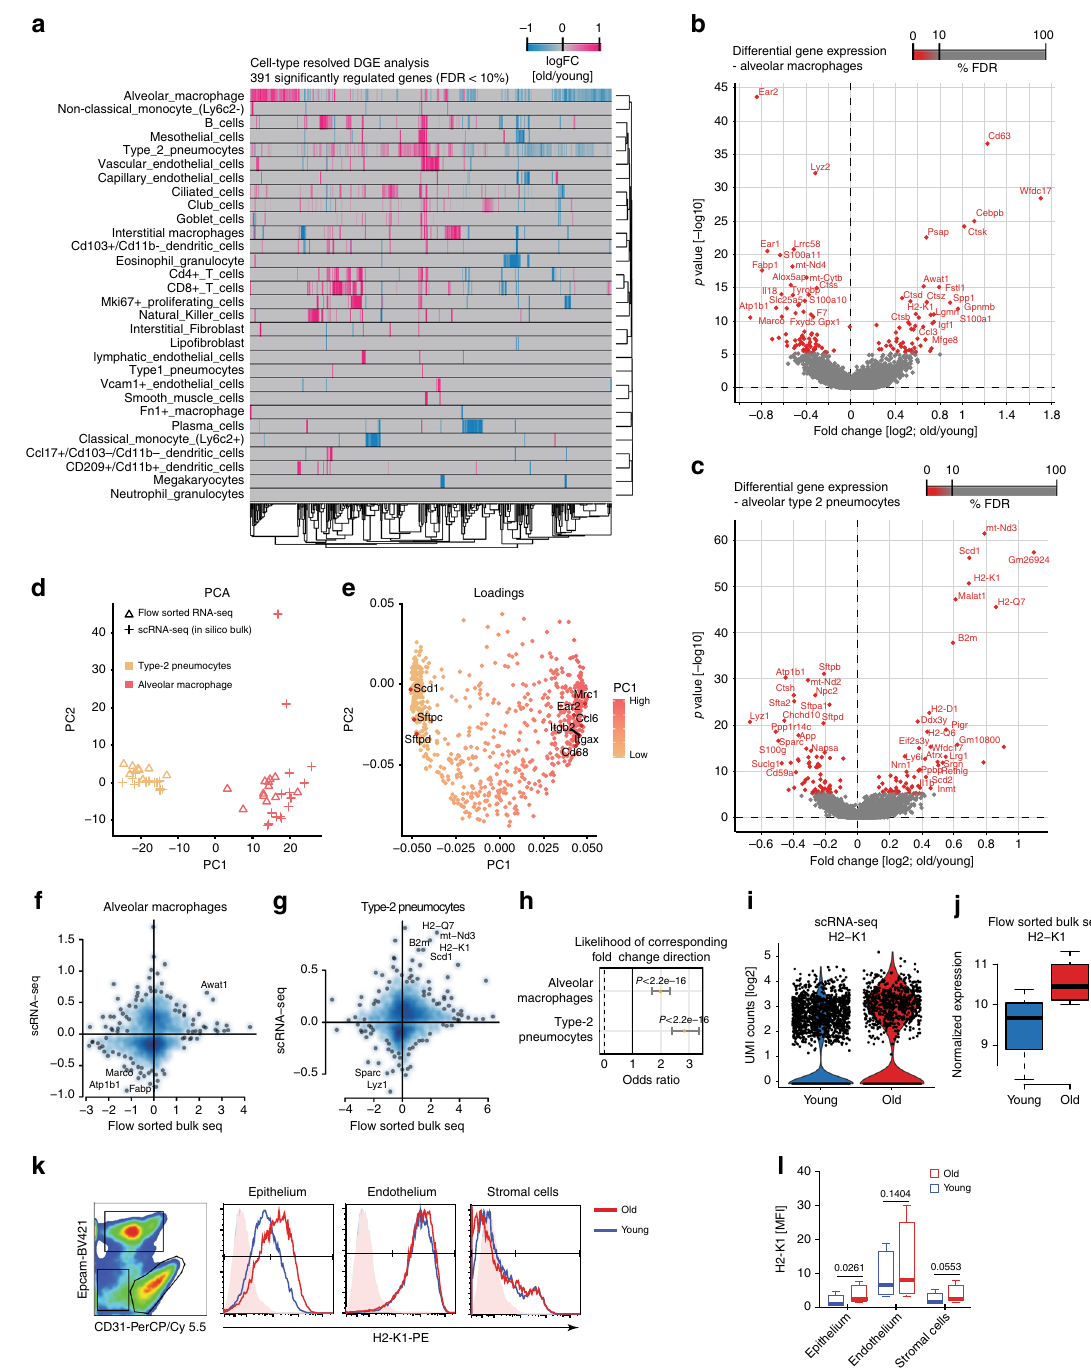
was speci fi c to alveolar type-2 cells (Fig. 8d). In addition, we used the Nile red dye to stain neutral lipids in cells of a whole lung suspension after depletion of leukocytes. Using fl ow cytometry we quanti fi ed the Nile red lipid staining and found a signi fi cant increase in mean fl uorescence intensity (Fig. 8e – g) in the CD45- negative cells of old mice. CD45 + cells were not signi fi cantly altered, indicating that the increase in neutral lipid content is speci fi c to epithelial cells and fi broblasts. Thus, we have shown that increased cholesterol biosynthesis and neutral lipid content in type-2 pneumocytes and lipo fi broblasts is a hallmark of lung aging. NATURE COMMUNICATIONS| (2019) 10:963